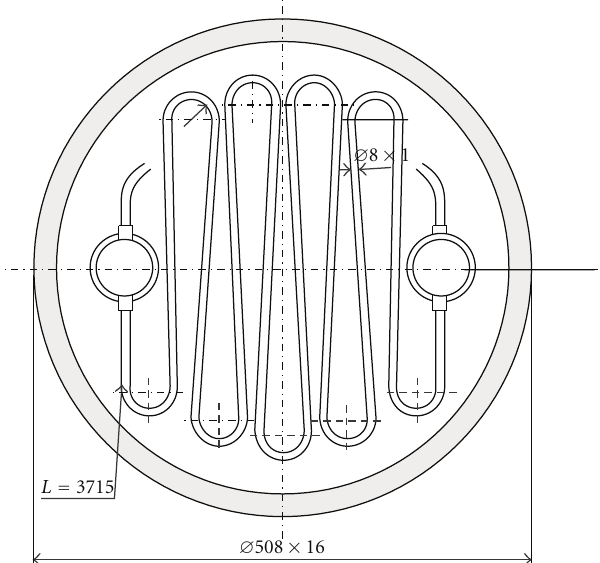
Figure 3: The cross section of the steam generator.